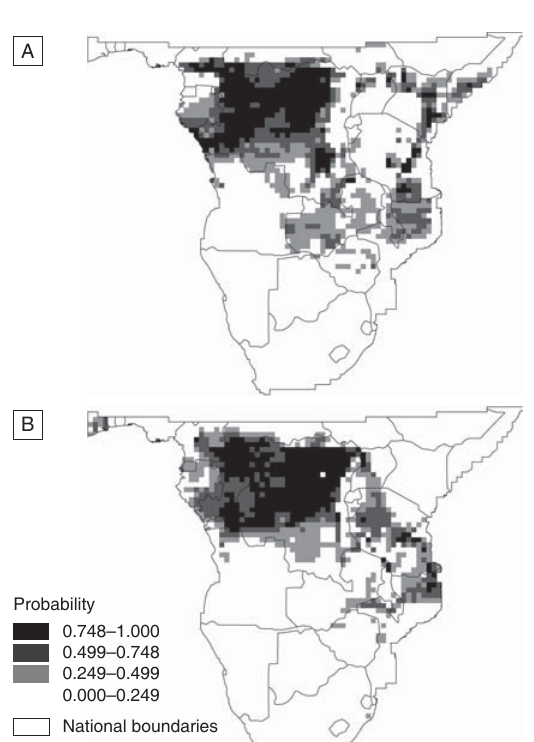
FIG. 14 R. capensis group FIG. 15 R. carnivoralis